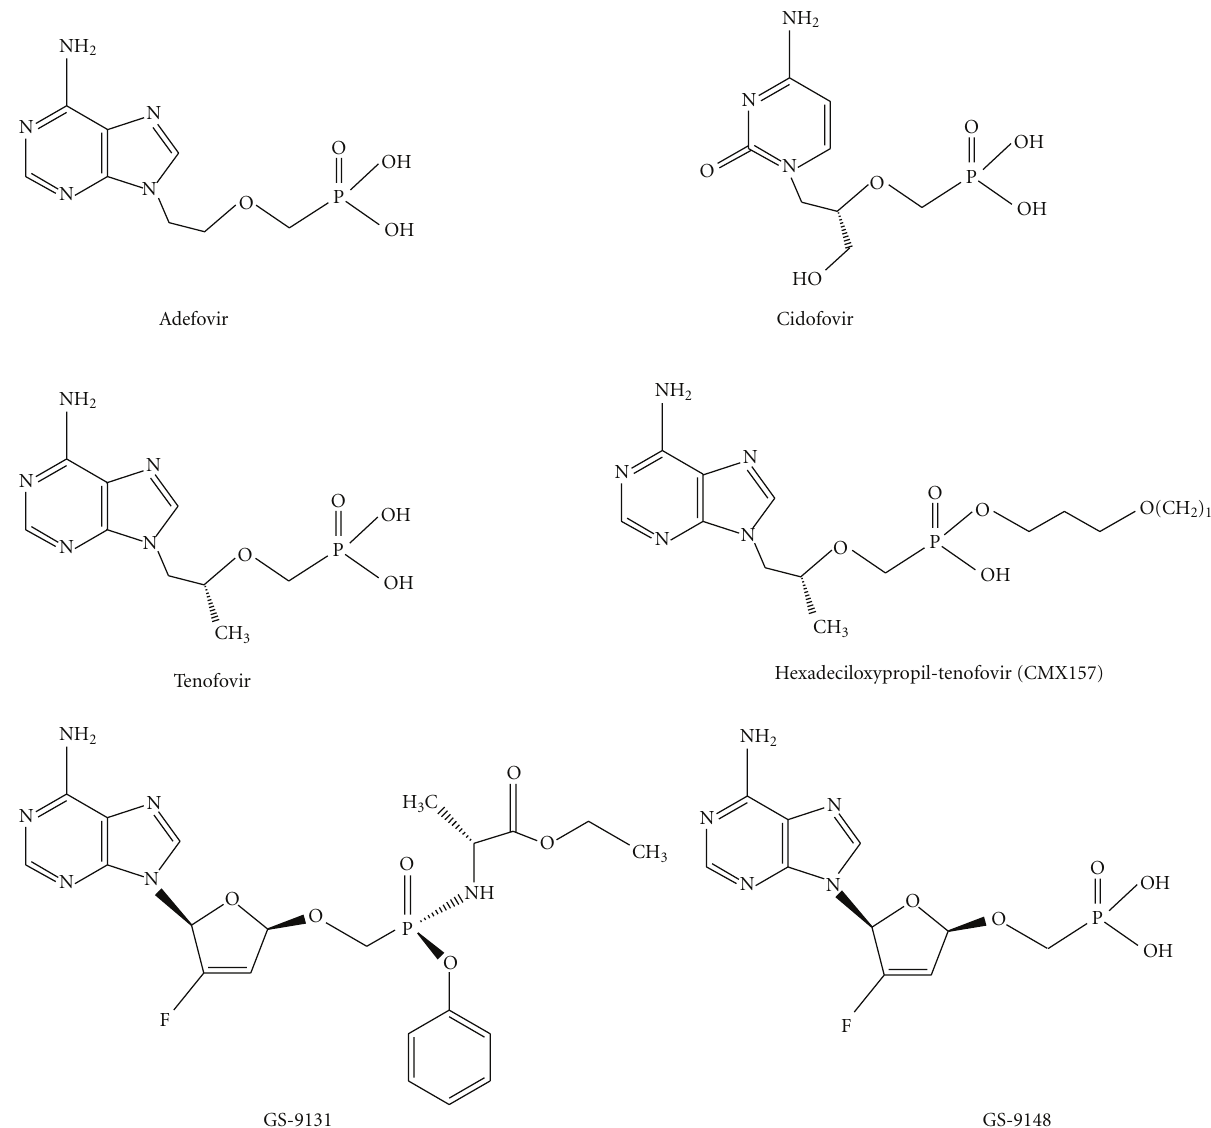
Figure 1: Chemical structure of the three main nephrotoxic acyclic nucleotide analogs, adefovir, cidofovir and tenofovir, as well as less nephrotoxic tenofovir derivatives under development. A lesser uptake by proximal tubular cells can be achieved by either esterifying the compounds with an alkoxyalkyl group, in e ff ect disguising them as lysophospholipids (hexadecyloxypropyl-tenofovir, CMX157) or by ribose-modification (GS-9148 and its oral prodrug